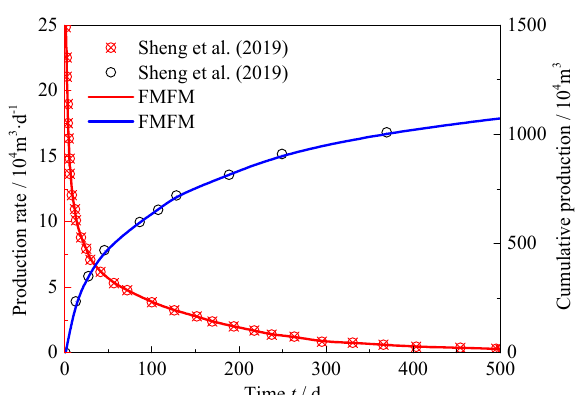
Figure 4. Comparison of production rate and cumulative production between FMFM and Sheng’s model [20].